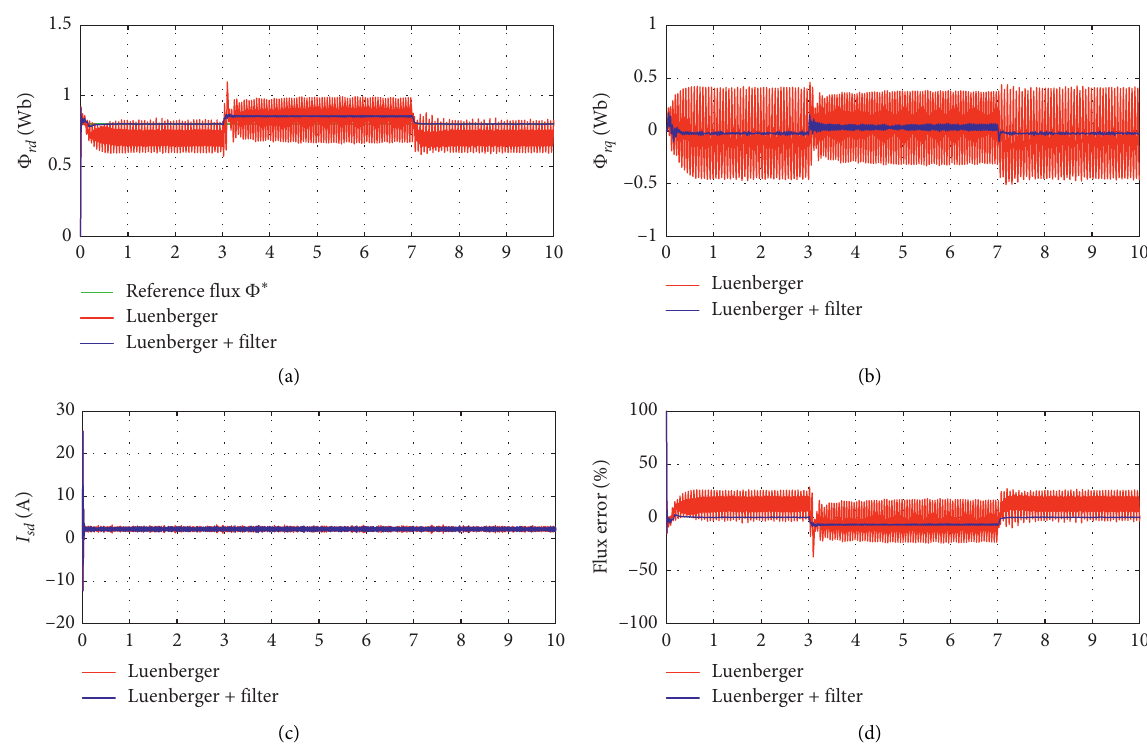
Figure 8: (a) d -axis rotor flux. (b) q -axis rotor flux. (c) d -axis stator current. (d) Flux error.